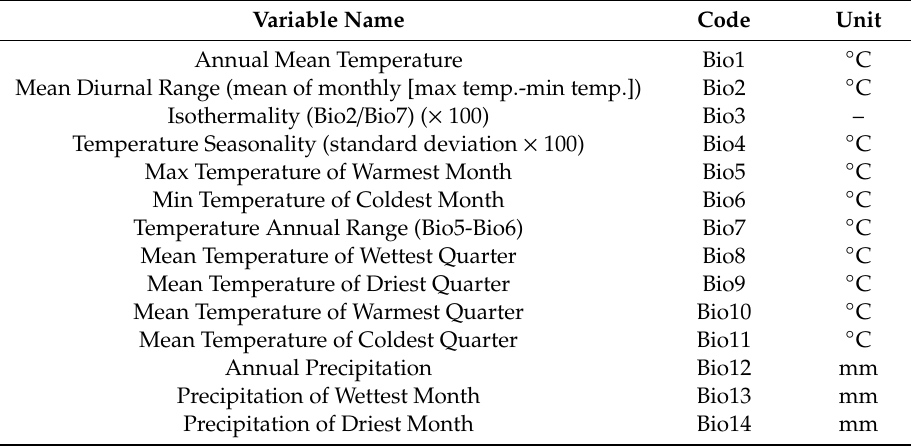
Figure 1. Distribution of the occurrence points of Cunninghamia lanceolata in China. Orange points represent data from The National Forest Continuous Inventory (NFCI) of China and blue points represent collected specimen data from the China National Specimen Information Infrastructure (NSII) and Chinese Virtual Herbarium (CVH). Table 1. Climate variables used for niche modelling.